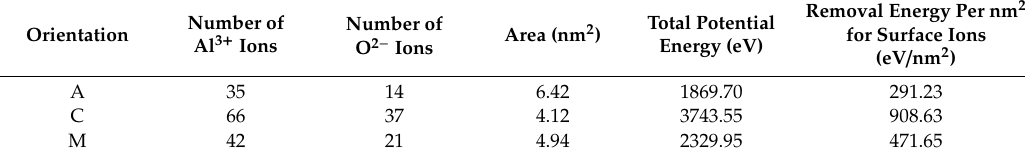
Figure 5. Crystal structure of sapphire ( a ) and expanded 2D arrangement of Al 3 + and O 2 − ions on the surface of A-plane ( b ), C-plane ( c ), and M-plane ( d ) sapphires. Table 1. Removal energy of Al 3 + and O 2 − ions per nm 2 on the sapphire surface.